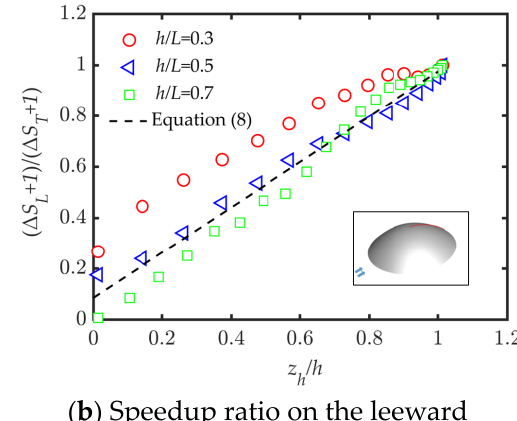
Figure 11. Hilltop speedup ratio with different slopes. Figure 12 shows the trend of the distribution of speedup ratios along the windward and leeward sides of the hill model for slopes of 0.3, 0.5, and 0.7, respectively. Figure 12a shows the results of dimensionless processing of the speedup ratio on the windward side of the hill model at different slopes with the maximum speedup ratio value. The comparison with Equation (7) shows the same trend, so it can be considered that the speedup ratio on the windward side at different slopes can be expressed by using Equation (7). Figure 12b shows the dimensionless speedup ratios on the leeward side at different slopes and, compared with Equation (8), it is found that the agreement is better, so Equation (8) can express the speedup ratios at different slopes.